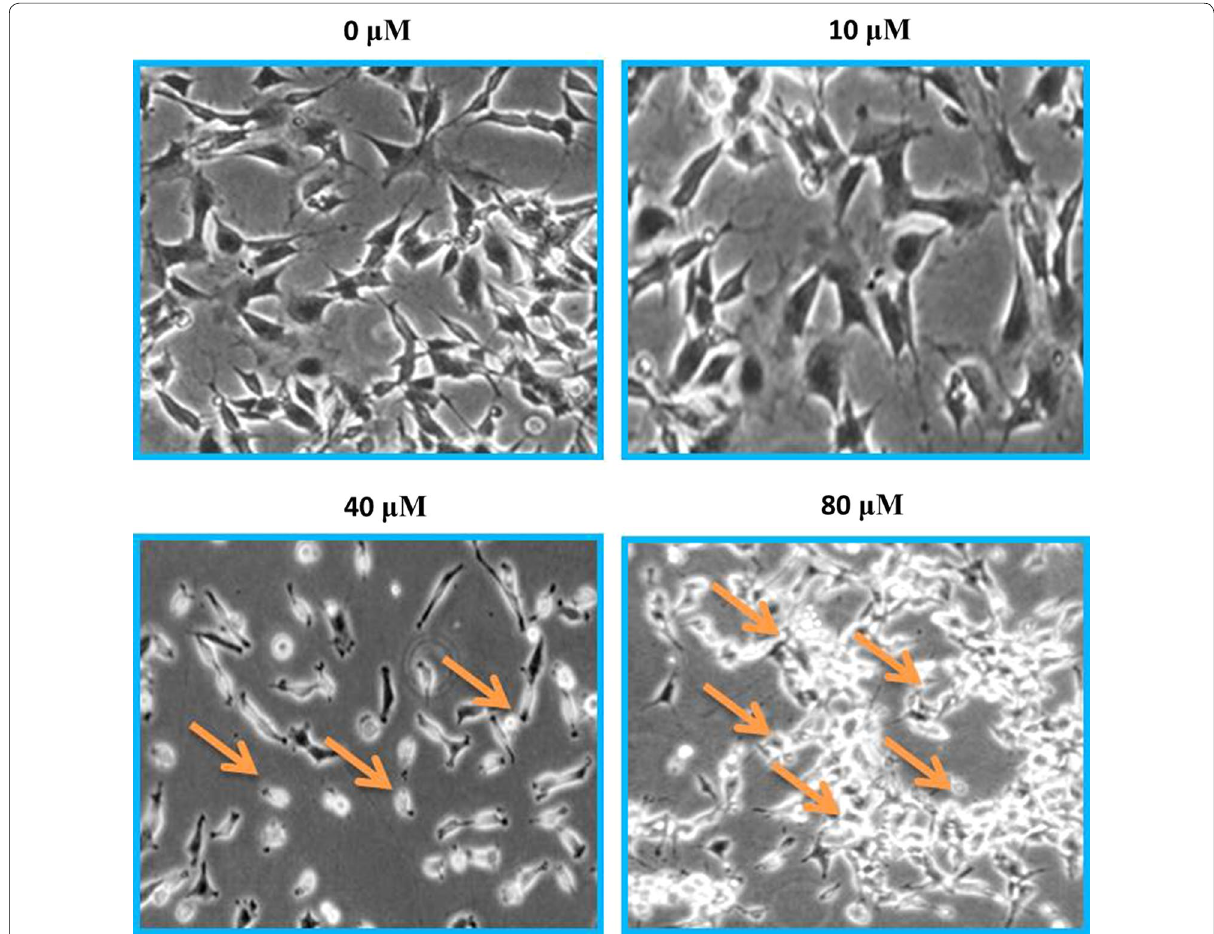
Fig. 3 Neuroblastoma SHSY-5Y cell line was subjected to changing maslinic acid doses viz 0, 10, 40 and 80 μM, for 24 h and ultimately with an inverted phase contrast microscope morphology was examined. Arrows indicate morphological changes that represent apoptosis including membrane blebbing, plasma membrane rupture and nuclear condensation. For maximum precision three individual experiments were